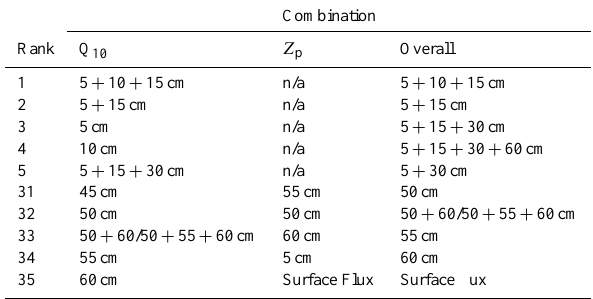
Table 4. Best and worst sensor combinations for determining Q 10 , Z p , and overall through